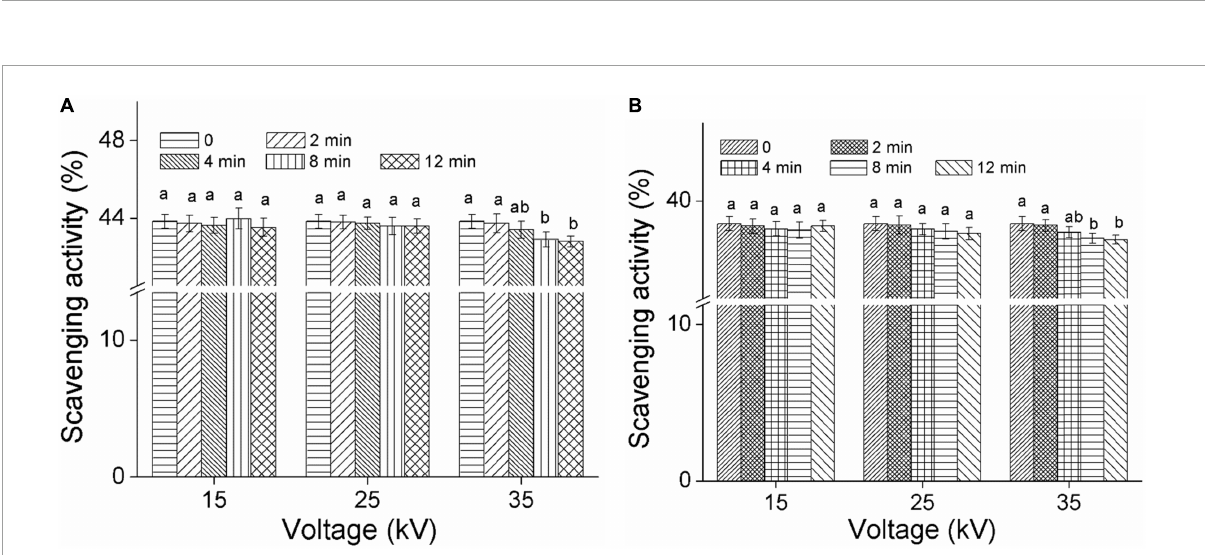
FIGURE4 Effect of DBD-ACP on DPPH free radical scavenging activity (%) of foxtail millet. (A) Mizhi. (B) Ansai.